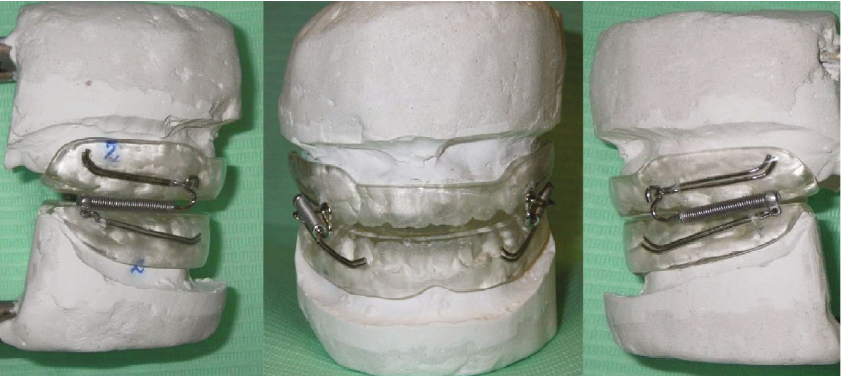
Figure 1: PS3 appliance.